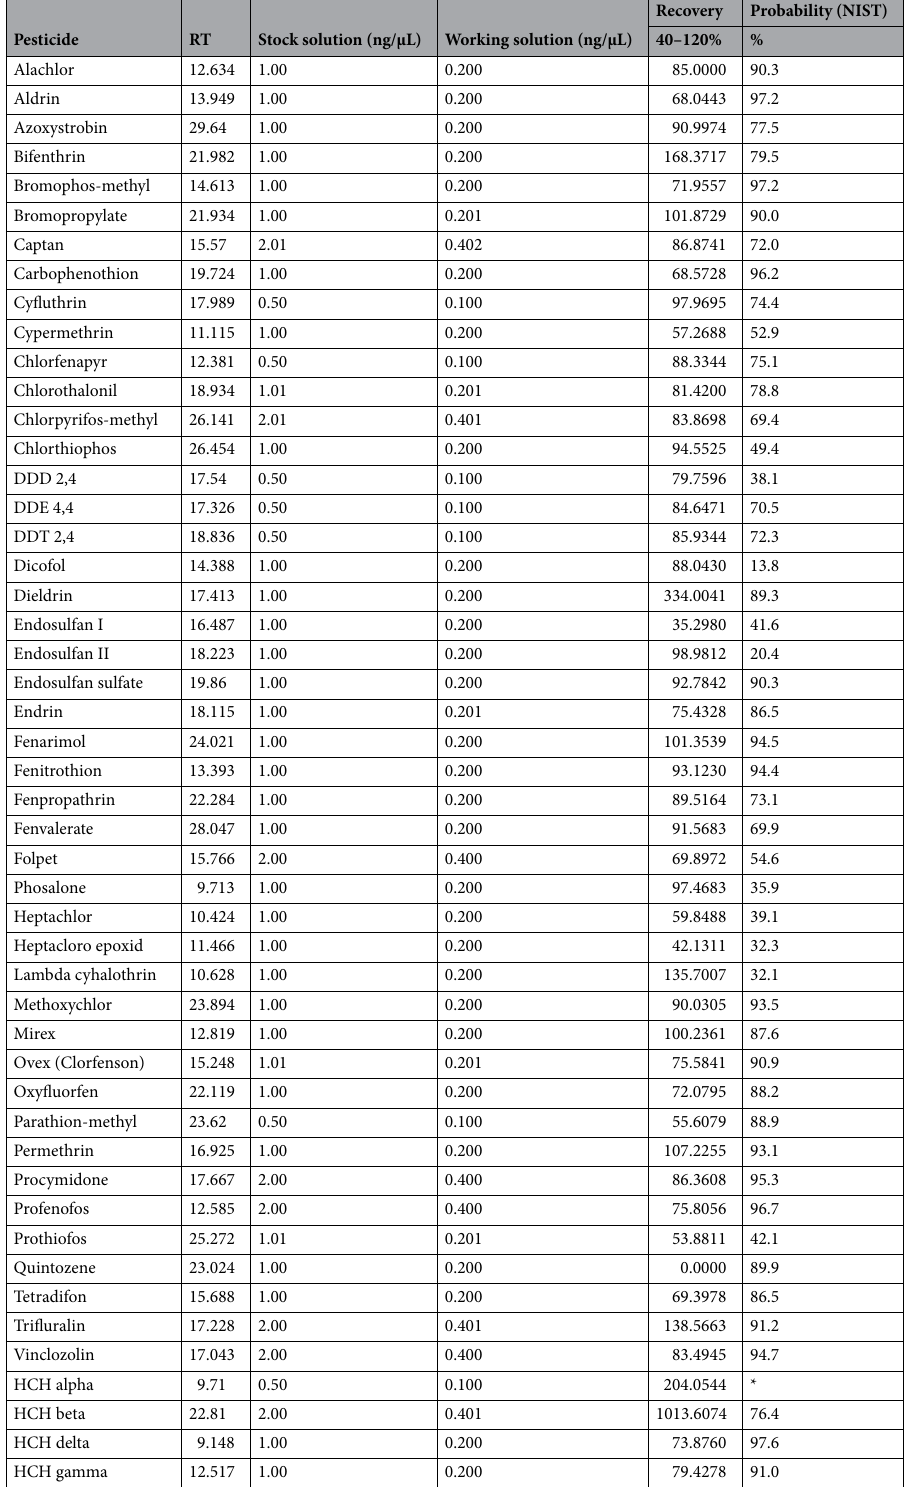
Table 2. Retention time (RT), stock and working solutions, recovery and probability obtained from the NIST library of thecompounds analyzed via gas chromatography coupled with mass spectrometry (GC–MS). * Analytical